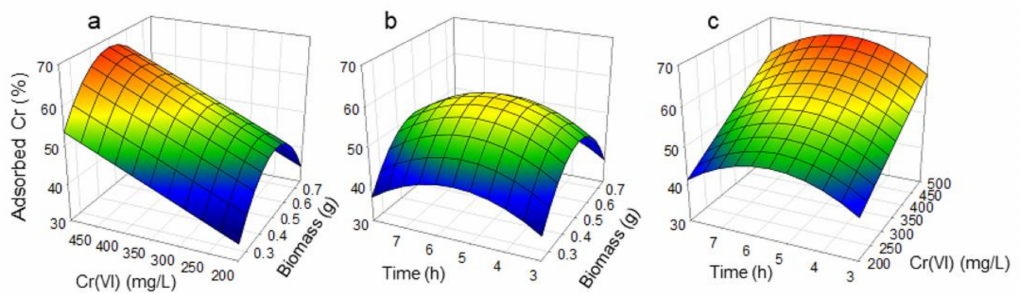
Figure 1. Surface response of the quadratic model in Equation (7) for the percentage of Cr adsorbed in the spirulina biomass versus ( a ) Cr concentration and biomass dose, ( b ) contact time and biomass dose, and ( c ) contact time and Cr